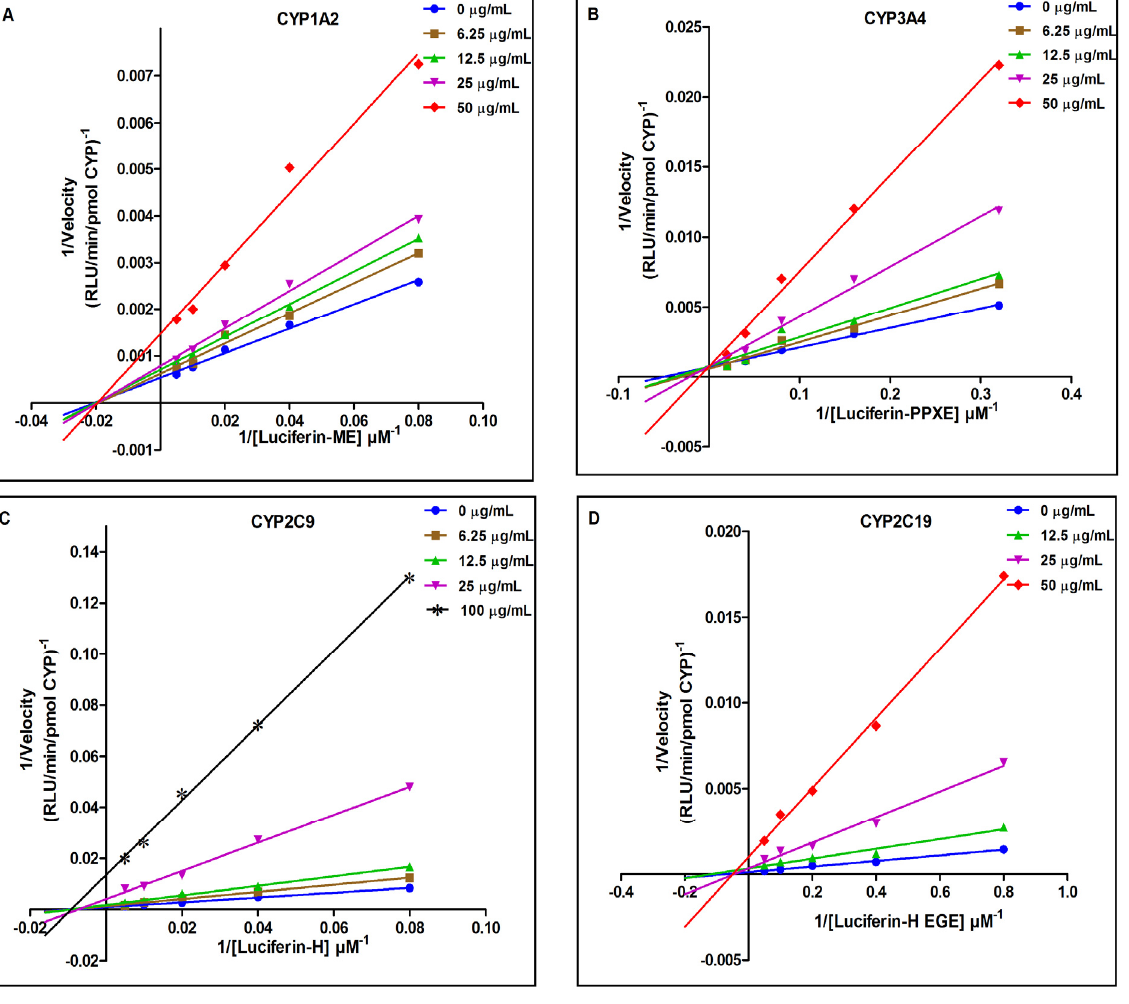
Figure 3. B. monnieri extract non-competitively inhibited CYP1A2, CYP2C9 and CYP2C19 activity and competitively inhibited CYP3A4 activity, as demonstrated by Lineweaver-Burk plots ( A ) CYP1A2; ( B ) CYP3A4; ( C ) CYP2C9 and ( D ) CYP2C19. The mode of inhibition was determined by incubating different concentrations of B. monnieri extract with increasing concentrations of substrates. Each point represents the average of duplicate